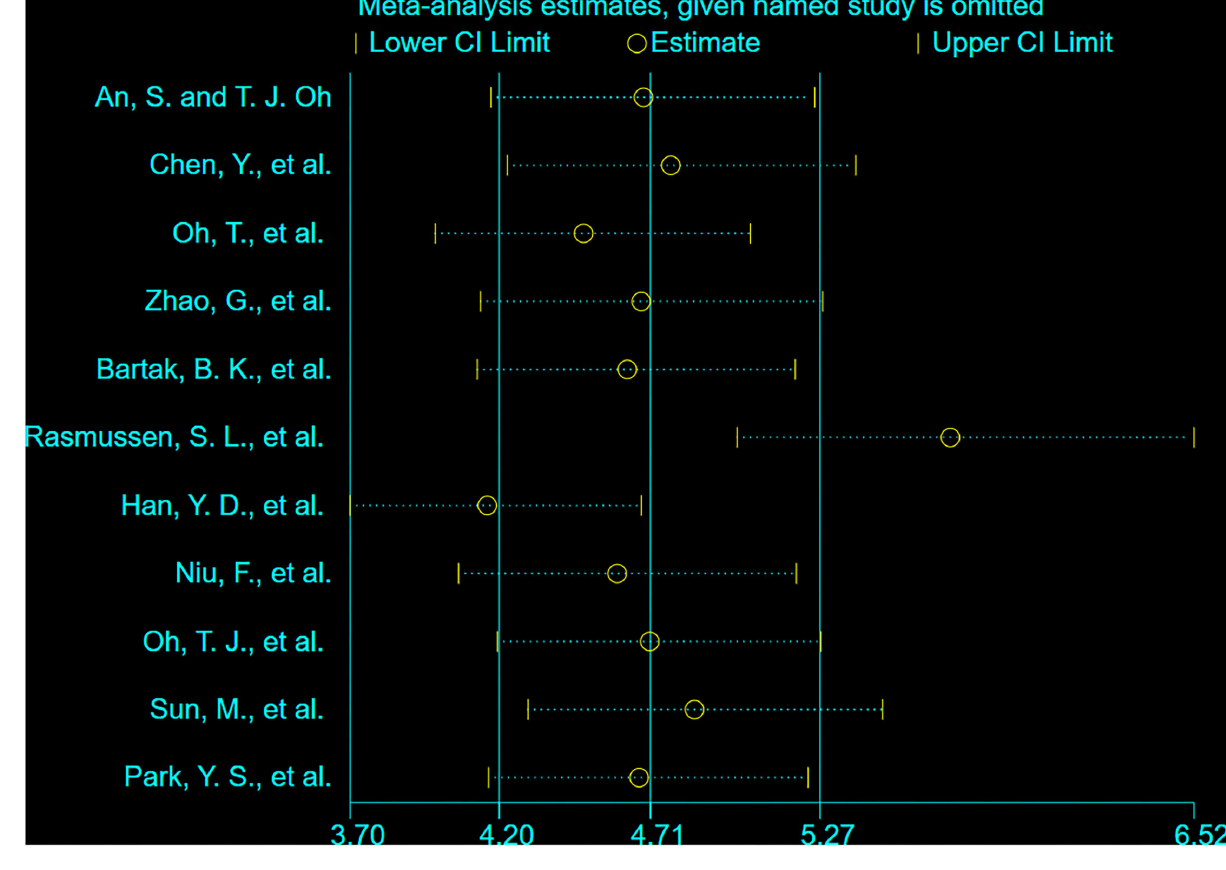
FIGURE 4 | The sensitivity analysis of the included